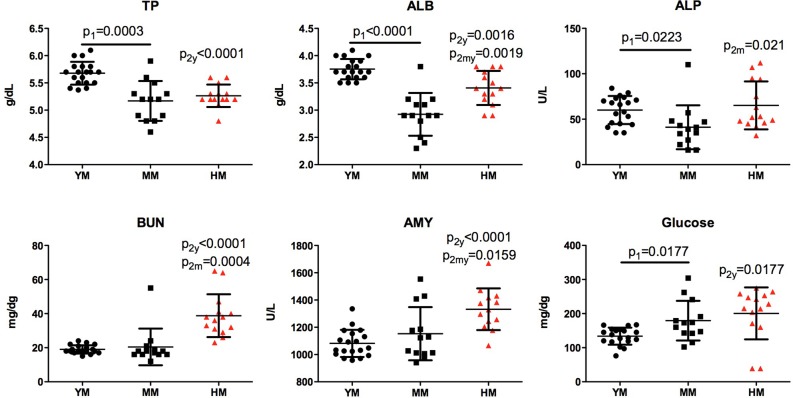
Age and humanization induced changes in blood biochemistry of NSG mice. Reduced total protein (TP) and albumin (ALB) concentration in middle age 12 month old (MM) and humanized (HM) NSG mice compared to young 6 month old (YM). Humanization associated increase is shown in alkaline phosphatase (ALP) and amylase (AMY) activity, blood urea nitrogen (BUN) and glucose concentrations. One-way ANOVA with post-hoc testing by Tukey's Multiple Comparison Test. Unpaired t-test with Welch's correction: p1 – differences between YM and MM; p2, p2y or p2m – difference between mice with or without humanization. Individual values, mean and s.d. are shown.